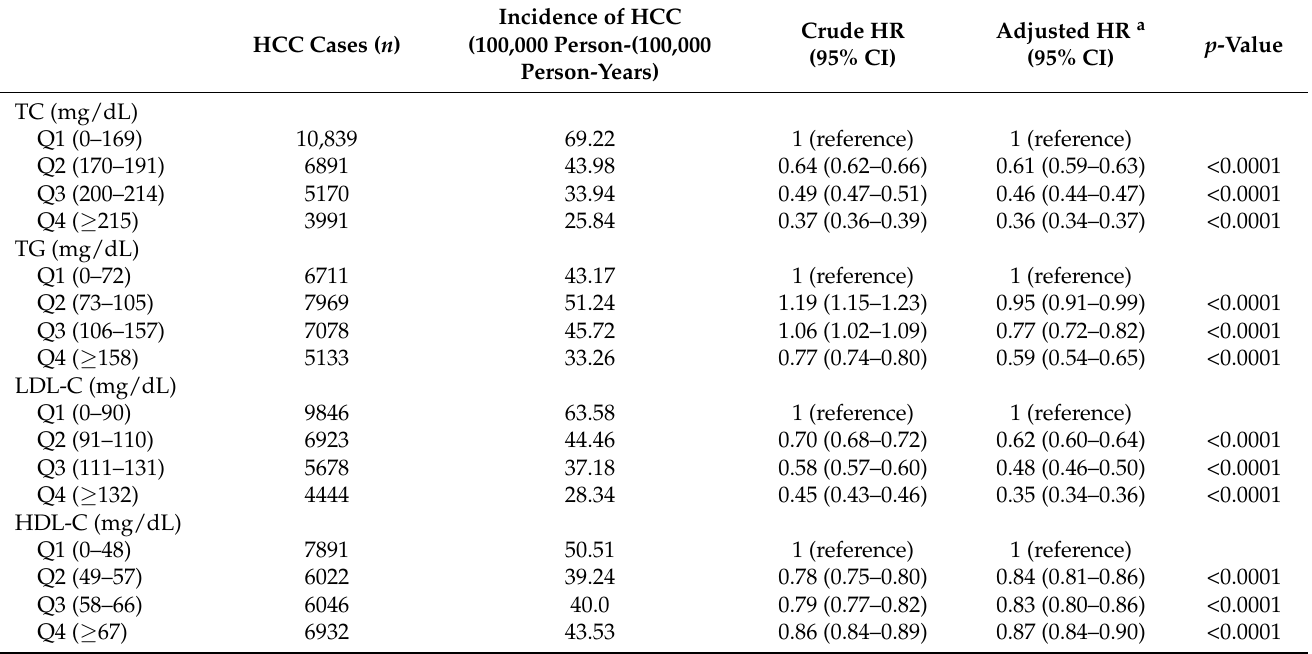
Table 2. Incidence of hepatocellular carcinoma (HCC) according to lipid profile